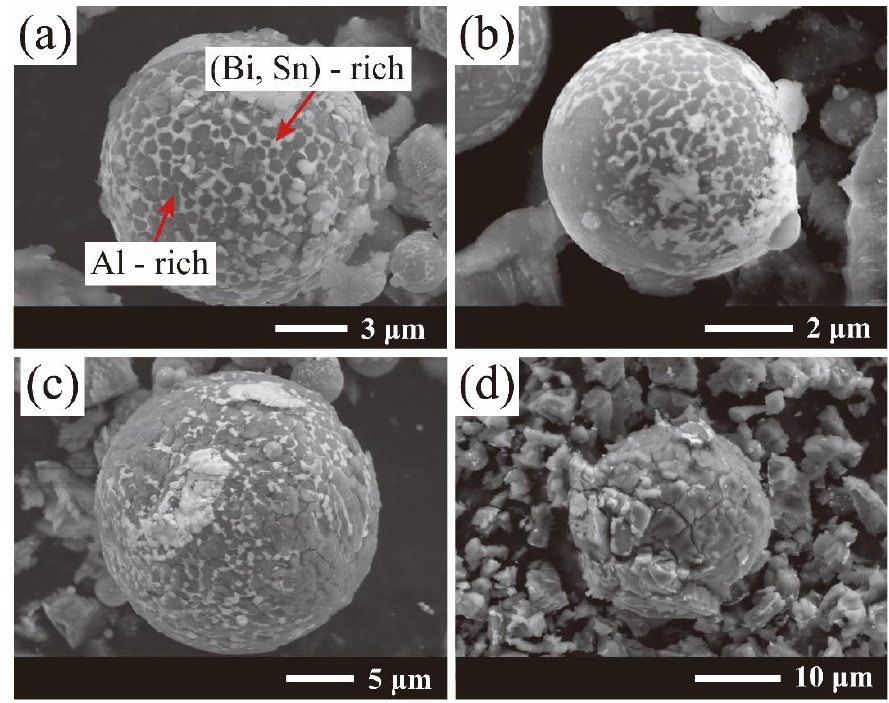
Figure 10. Surface morphologies of the Al-10Bi-7Sn-xFe (x = 0, 1.5) (wt.%) composite powders exposed to air for different times (25 ◦ C and 60 RH%): ( a ) Al-10Bi-7Sn-1.5Fe (wt.%), 12 h; ( b ) Al-10Bi- 7Sn-1.5Fe (wt.%), 24 h; ( c ) Al-10Bi-7Sn-1.5Fe (wt.%), 72 h; ( d ) Al-10Bi-7Sn (wt.%), 12 h